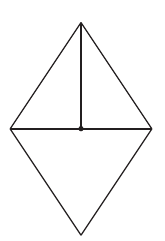
Figure 4: Example of nonconforming mesh in R 2